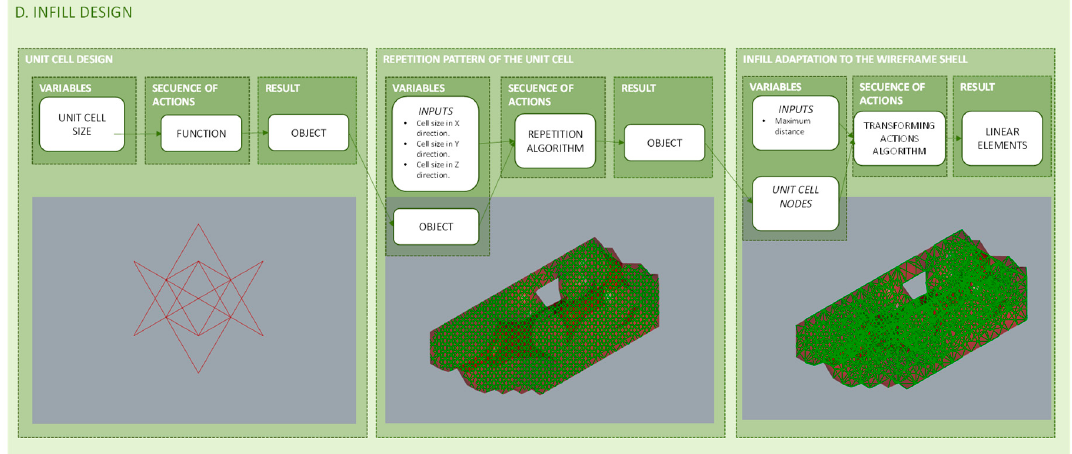
Figure 11. Programming structure for infill design and for its adaptation to the lightweight shell structure. shell